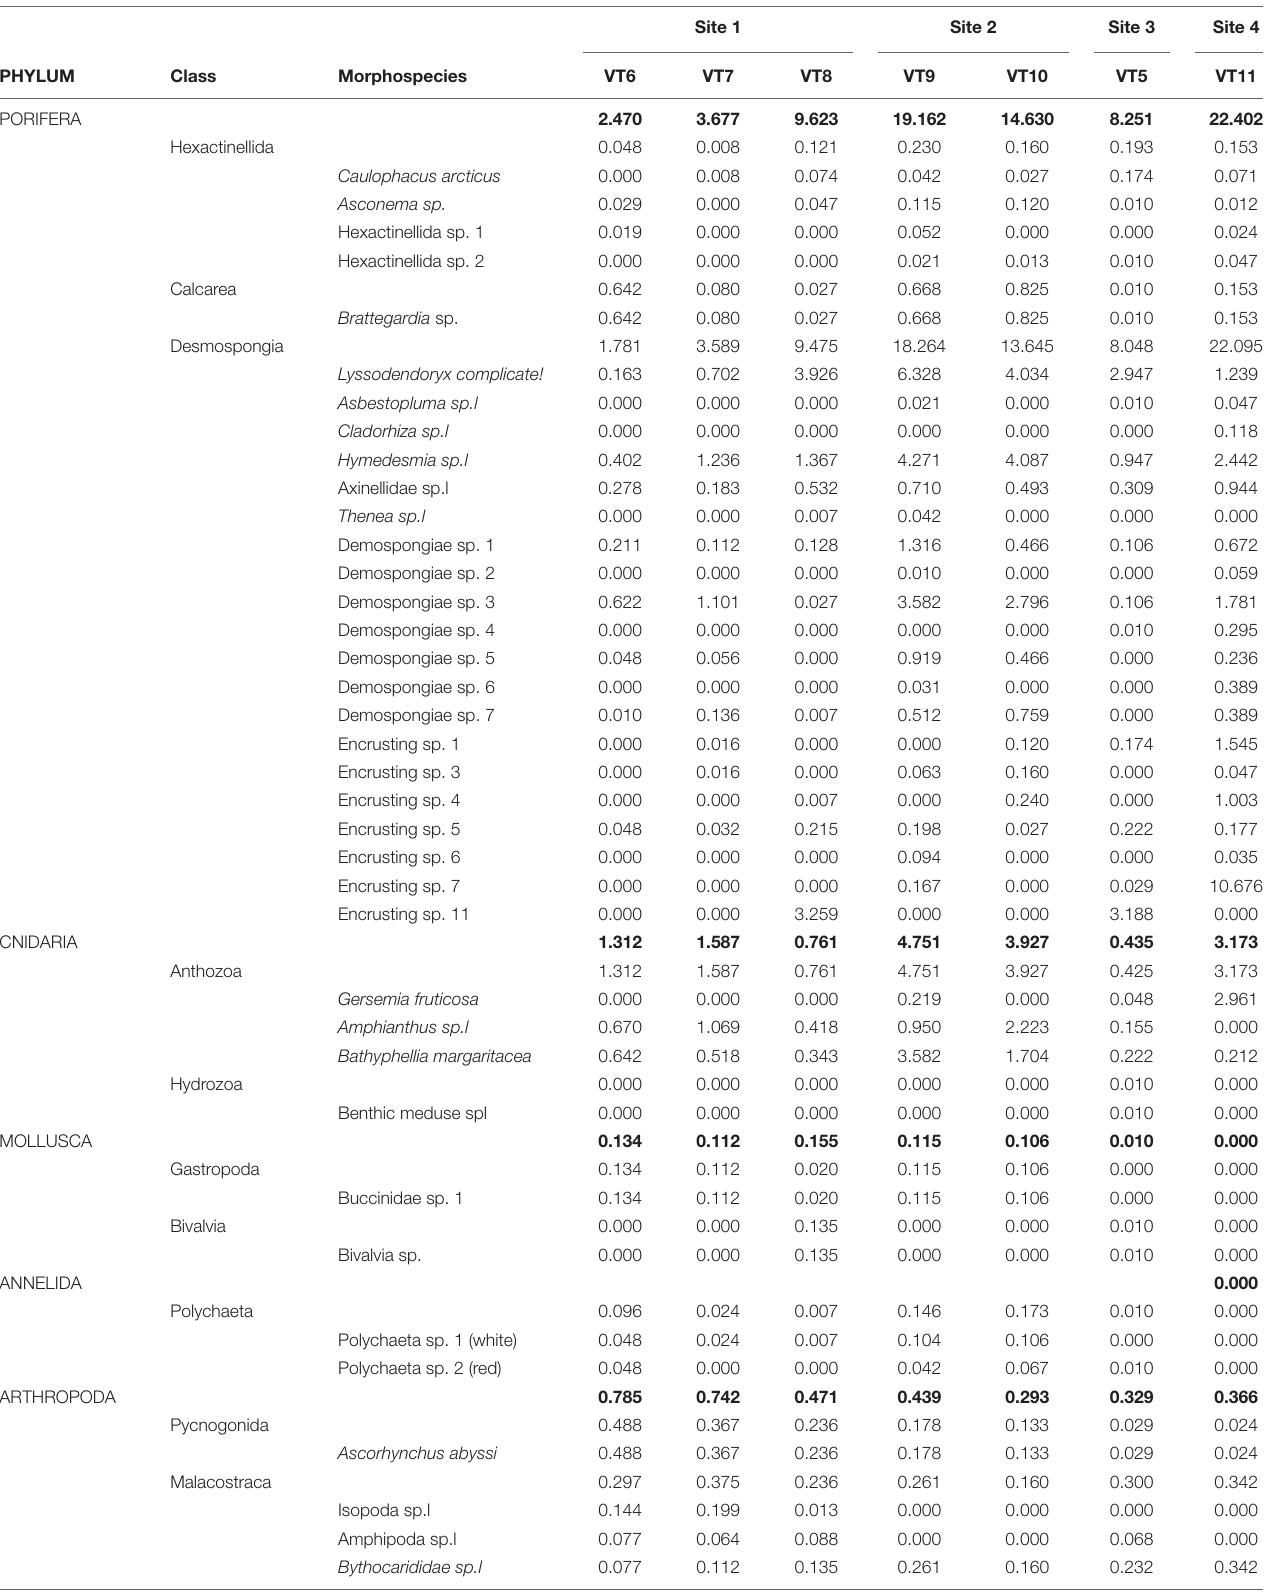
TABLE 2 | Density (ind.m − 2 ) of the different morphospecies observed in Mohn’s Treasure.